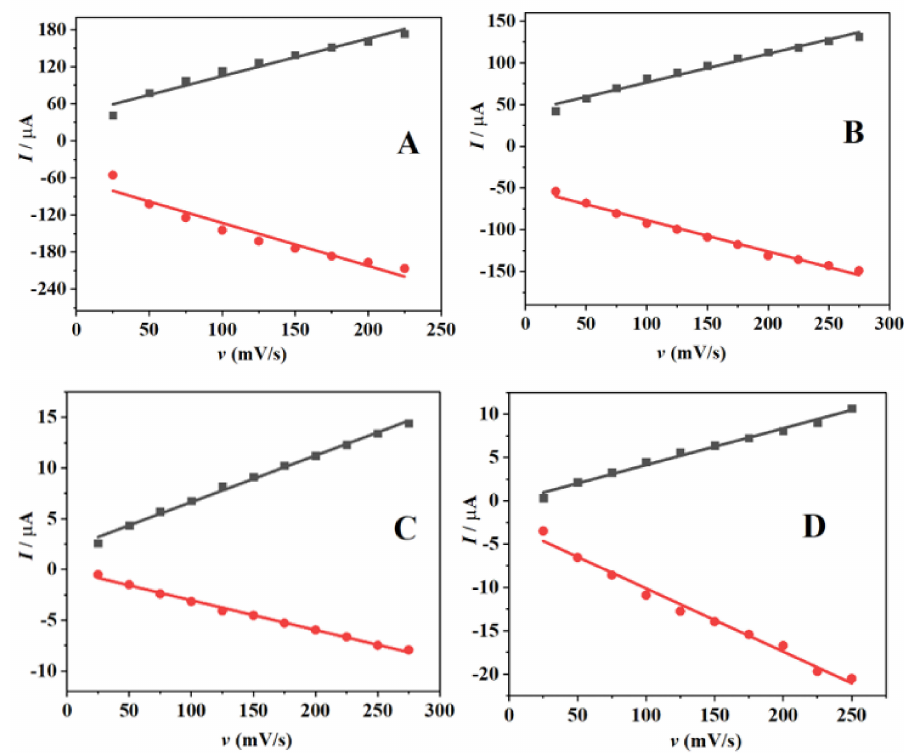
Figure 8. A linear relationship between I p and v for ( A ) SPAuE, ( B ) SPAuE-CuO, ( C ) SPAuE-SPEEK, and ( D ) SPAuE-SPEEK-CuO.